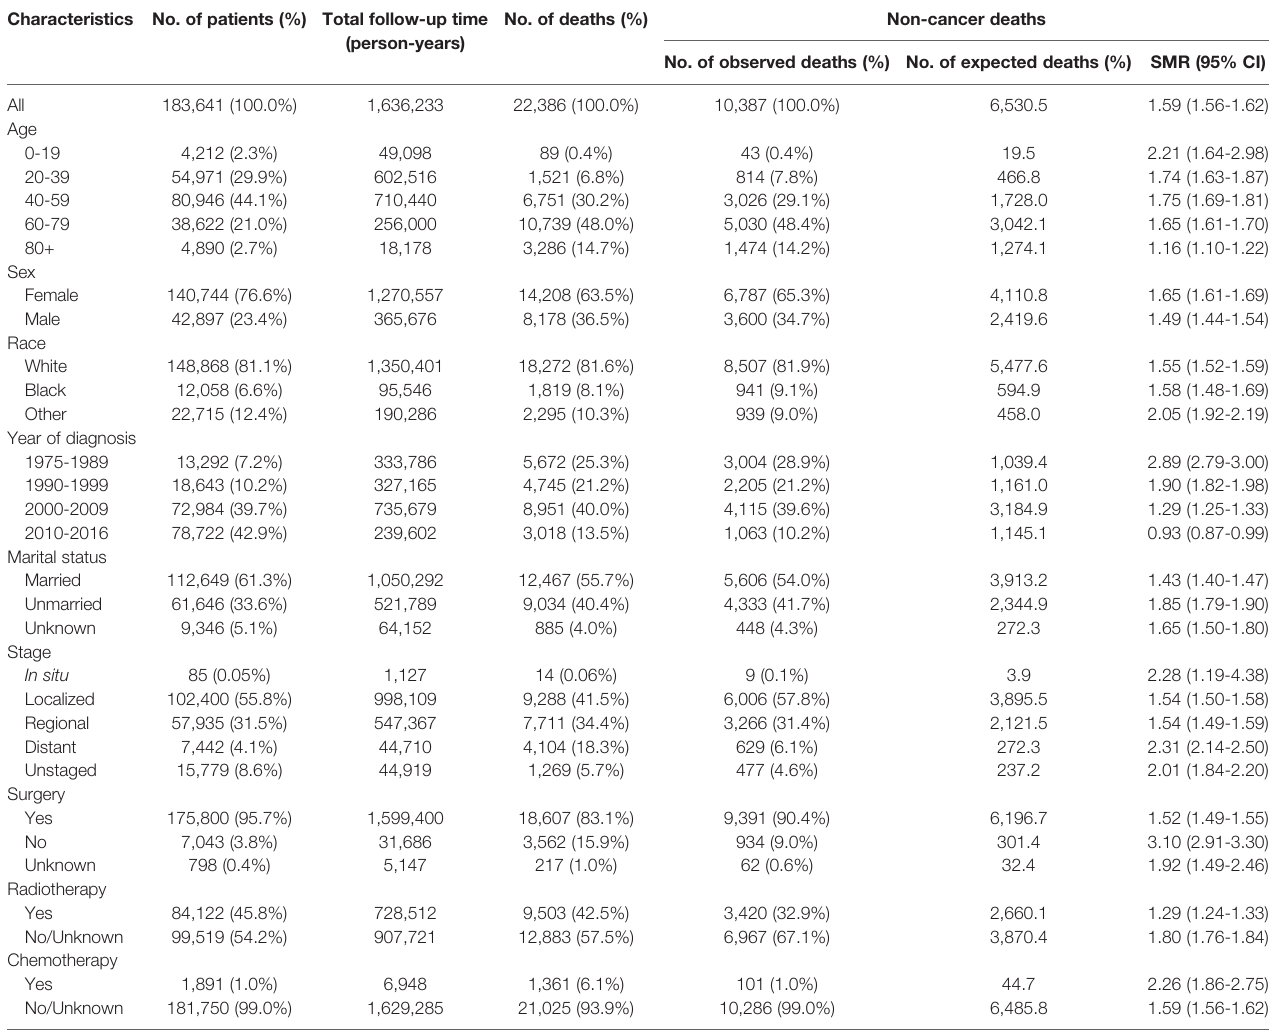
TABLE 1 | Characteristics of patients diagnosed with fi rst primary thyroid cancer from 1975 to 2016 in the SEER program. Characteristics No. of patients (%) Total follow-up time No. of deaths (person-years)